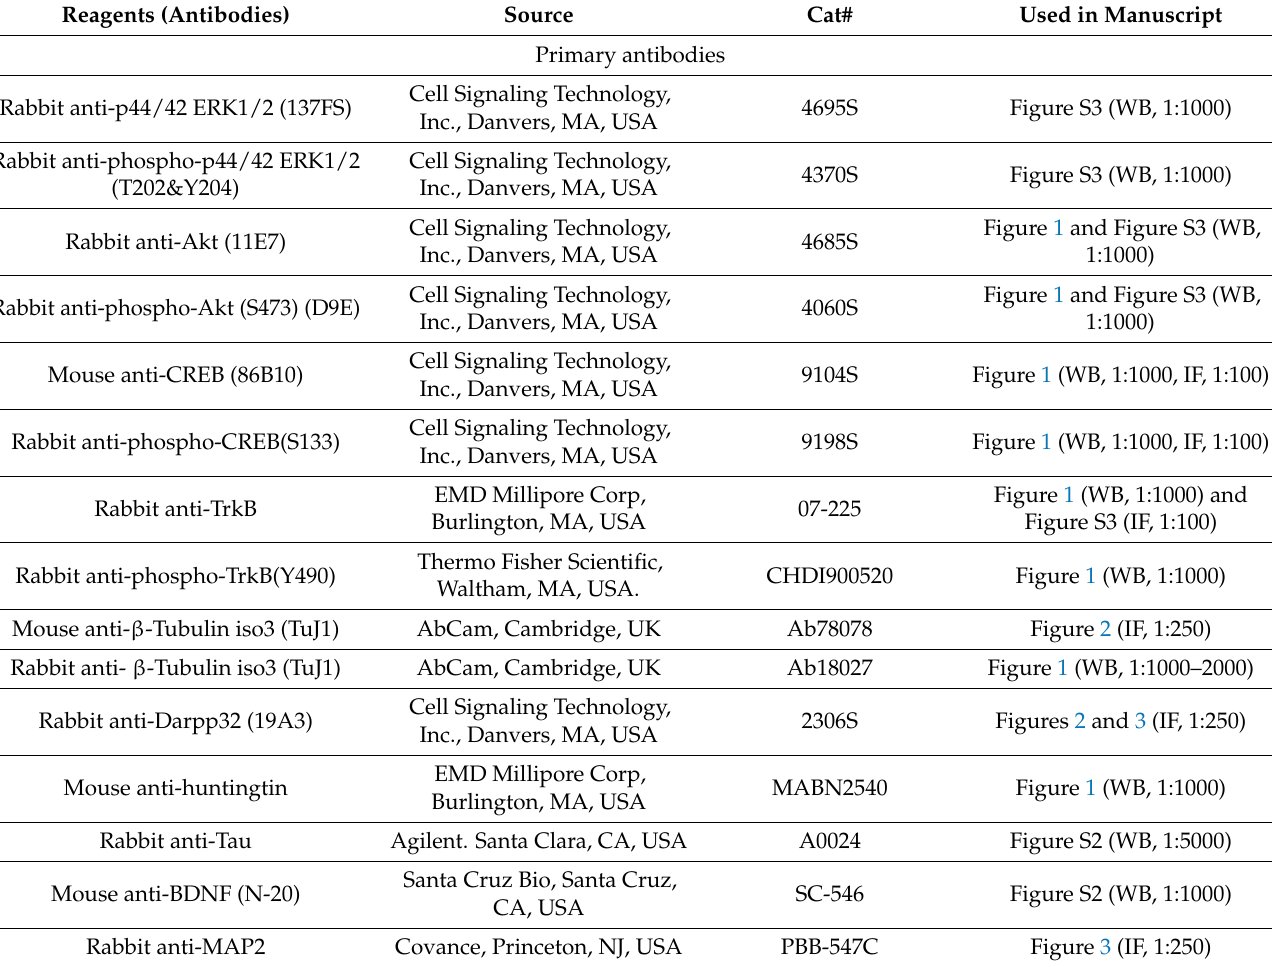
Table 1. List of all antibodies used along with their catalog